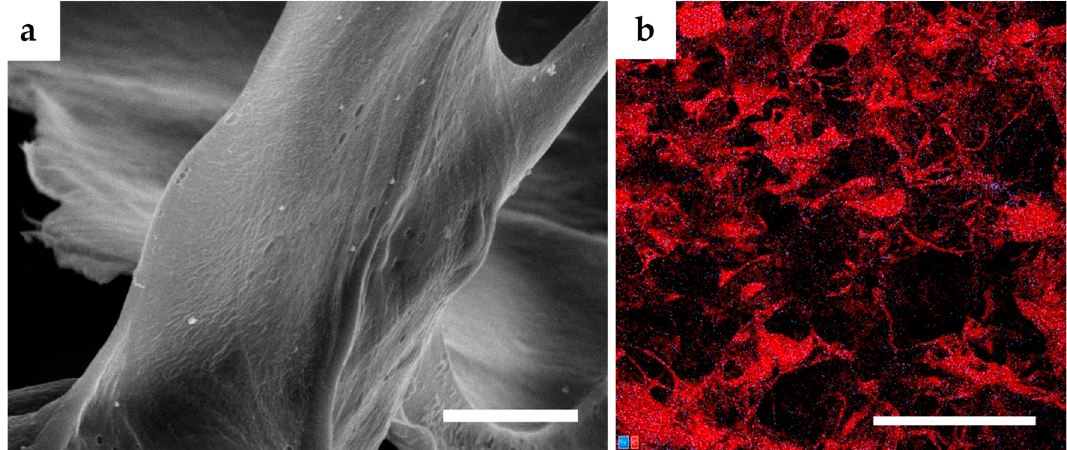
Figure 2. ( a ) SEM image of the C/SeCH scaffold acquired at 25,000× magnification with a scale of 5 µm; ( b ) energy-dispersive X-ray analysis image of the C/SeCH scaffold acquired at 175× magnification with a scale of 500 µm. The red color represents carbon elements and the blue color represents selenium elements.